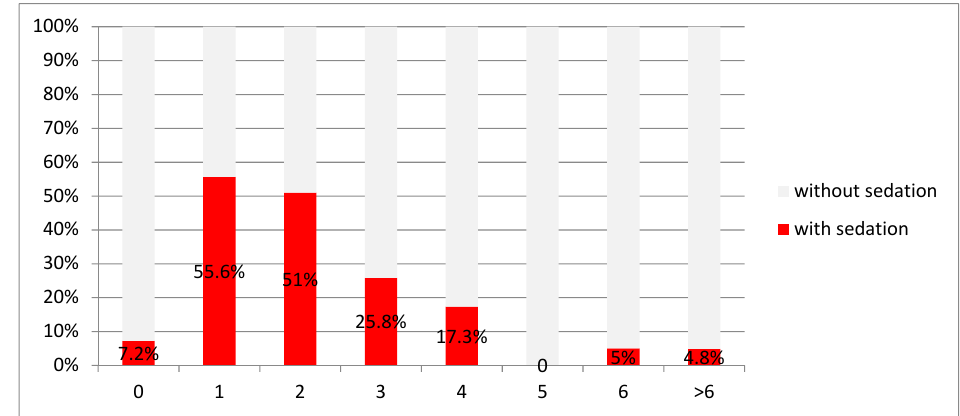
Figure 1. Age-related sedation rate (Part 2: primary data Figure 1: Age related sedation rate. (Part two- primary data assessment)